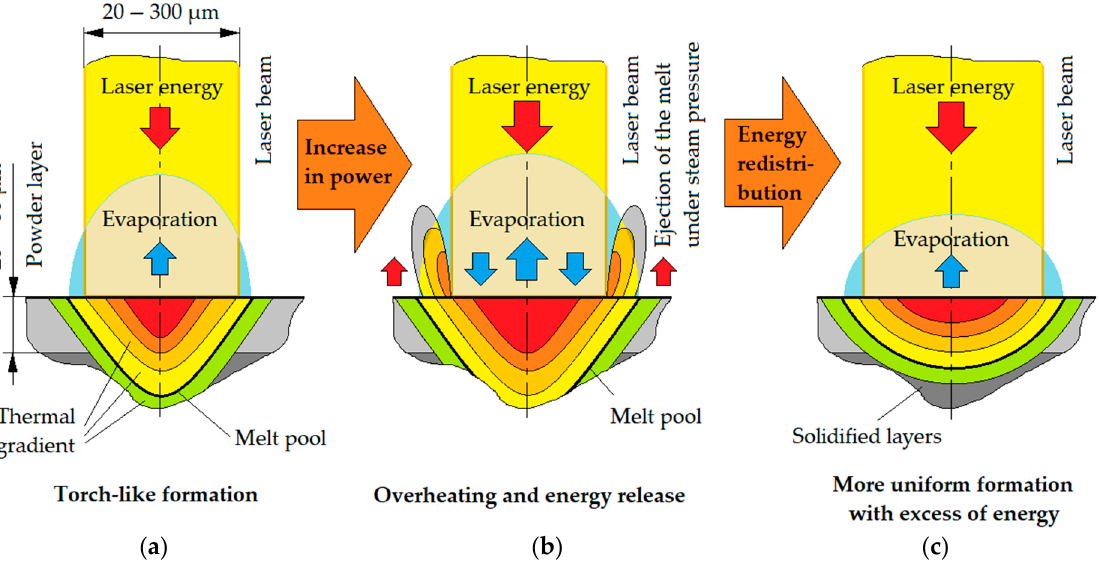
Figure 11. Melt pool formation: ( a ) torch-like; ( b ) torch-like with an increase of energy in the laser beam; ( c ) more uniform surface-like with an increase of redistributed energy in the melt pool.